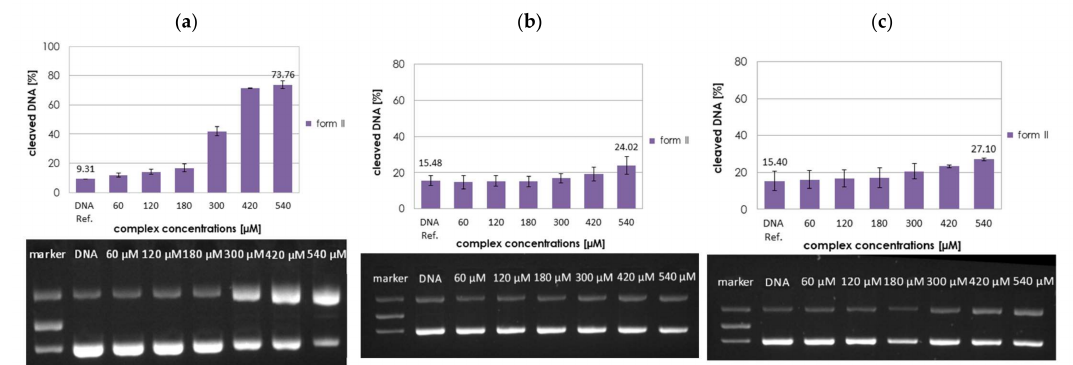
Figure 4. Cleavage of pBR322 plasmid DNA (0.025 µ g/ µ L) into form II by the complexes [Cu(L)(ClO 4 )]ClO 4 at concentra- tions in the range of 60–540 µ M after an incubation time of 2 h, at pH 7.4 (10 m M MOPS) and 37 ◦ C. ( a ) 1-ClO 4 , ( b ) 2-ClO 4 , and ( c ) 3-ClO 4 , Lane 1: marker and Lane 2: control without added complex.